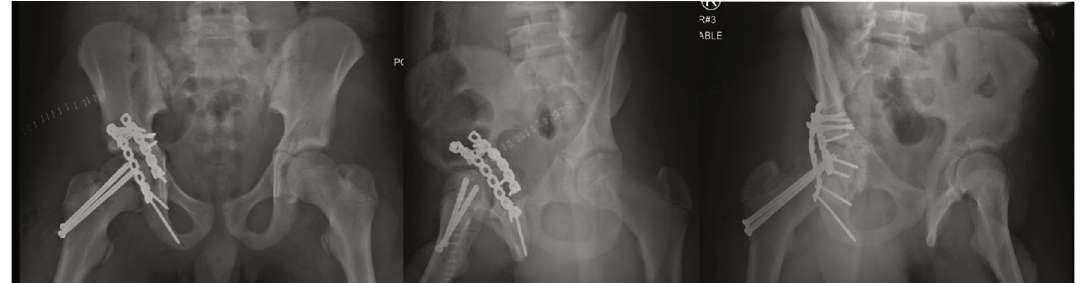
Figure 4: Postoperative AP and Judet pelvis radiographs demonstrating the fi xation of right acetabulum and concentric reduction of right femoral